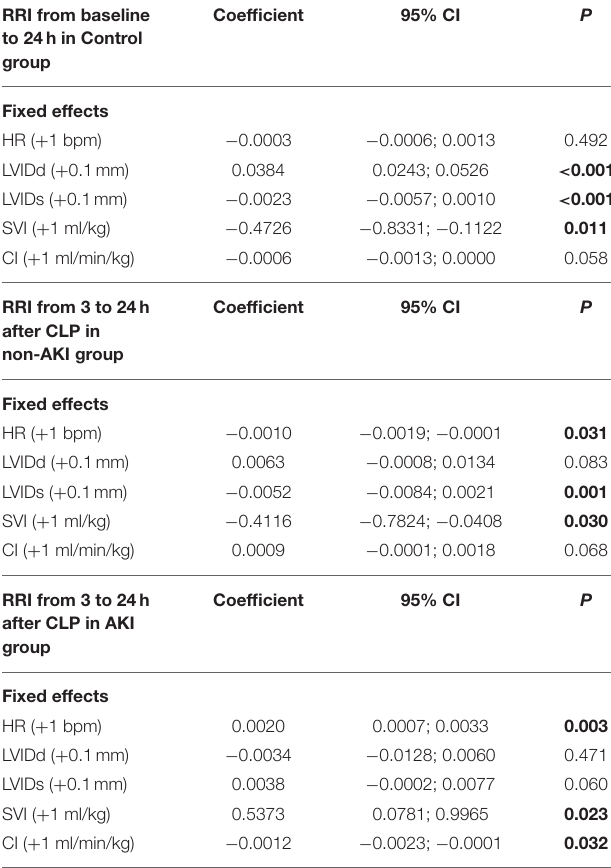
TABLE 3 | Linear mixed model for predicting renal resistive index (RRI). RRI from baseline to 24h in